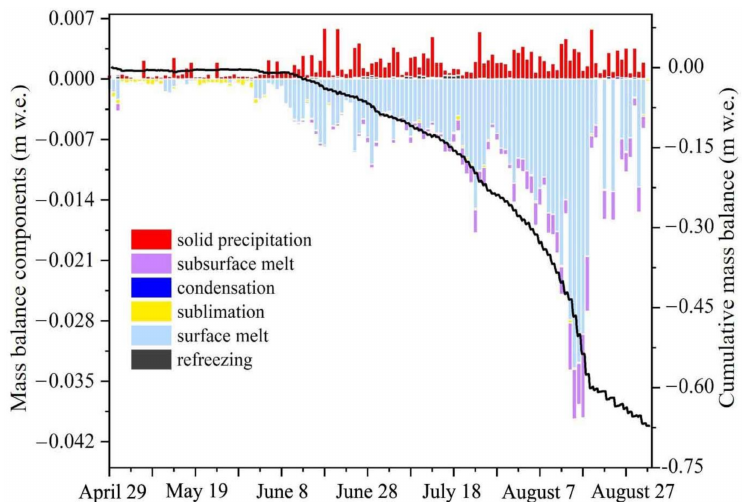
Figure 5. Mass balance components and cumulative mass balance at the site of AWS1 on UG1 during the study period. Glacier mass balance is the sum of solid precipitation, refreezing-surface melt, condensation (positive) and surface and subsurface melt and sublimation